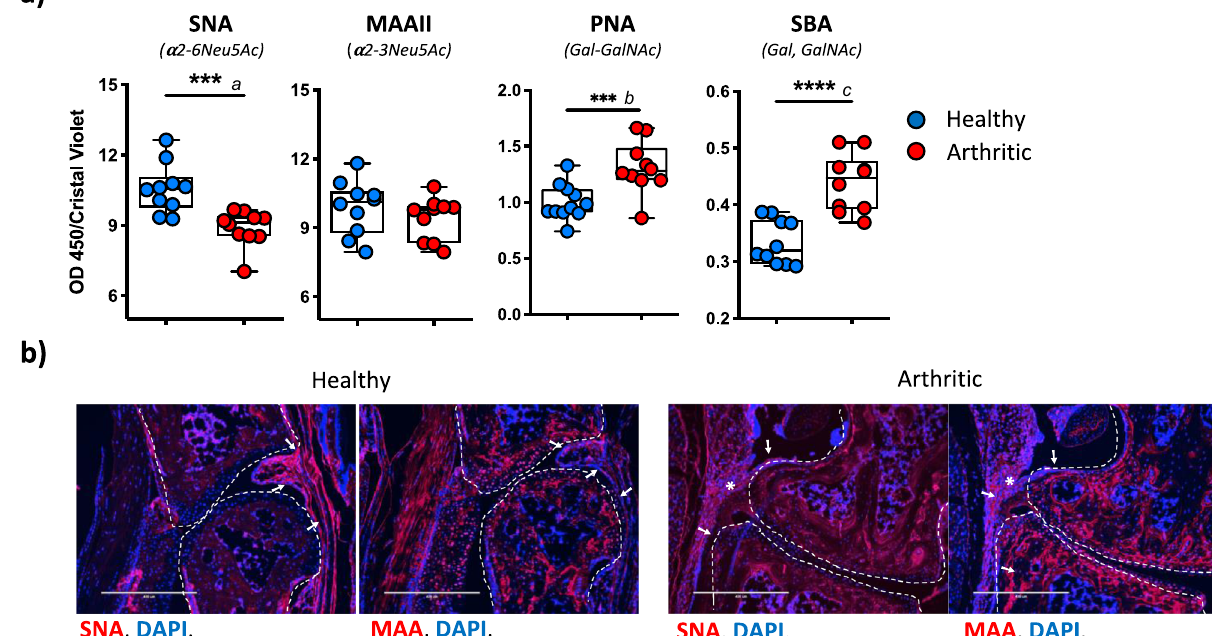
Fig. 4 Synovial fi broblasts from arthritic mice have reduced levels of α 2-6 but not α 2-3-sialylation. a SNA, MAAII, PNA, and SBA lectins were used in enzyme-linked lectin assay (ELLA) to evaluate the presence of α 2-6 Sialic acid, α 2-3 sialic acid, non-sialylated T antigen, and terminal N-acetylgalactosamine/galactose respectively. n = 10 biological replicates from three independent experiments. Statistics: two-tail unpaired t -test, n = 10. * p < 0.05, ** p < 0.01, *** p < 0.001. Actual p -values: a 0.0007, b <0.00001, c 0.0018. Boxplots show 25th to 75th percentiles and median, whiskers from minimum to maximum. b Mouse joint sections were stained with biotinylated SNA and MAAII and fl uorescently labeled streptavidin. Magni fi cation ×20, scale bars: 400 μ m. Lectin binding is shown in red, nuclei counterstain with DAPI in blue. Superimposed white elements indicate as follows; [dotted lines]: bone limits, [arrows]: synovial membrane, [asterisks]: local in fl ammation and in fi ltrating cells. The experiment was repeated twice with similar